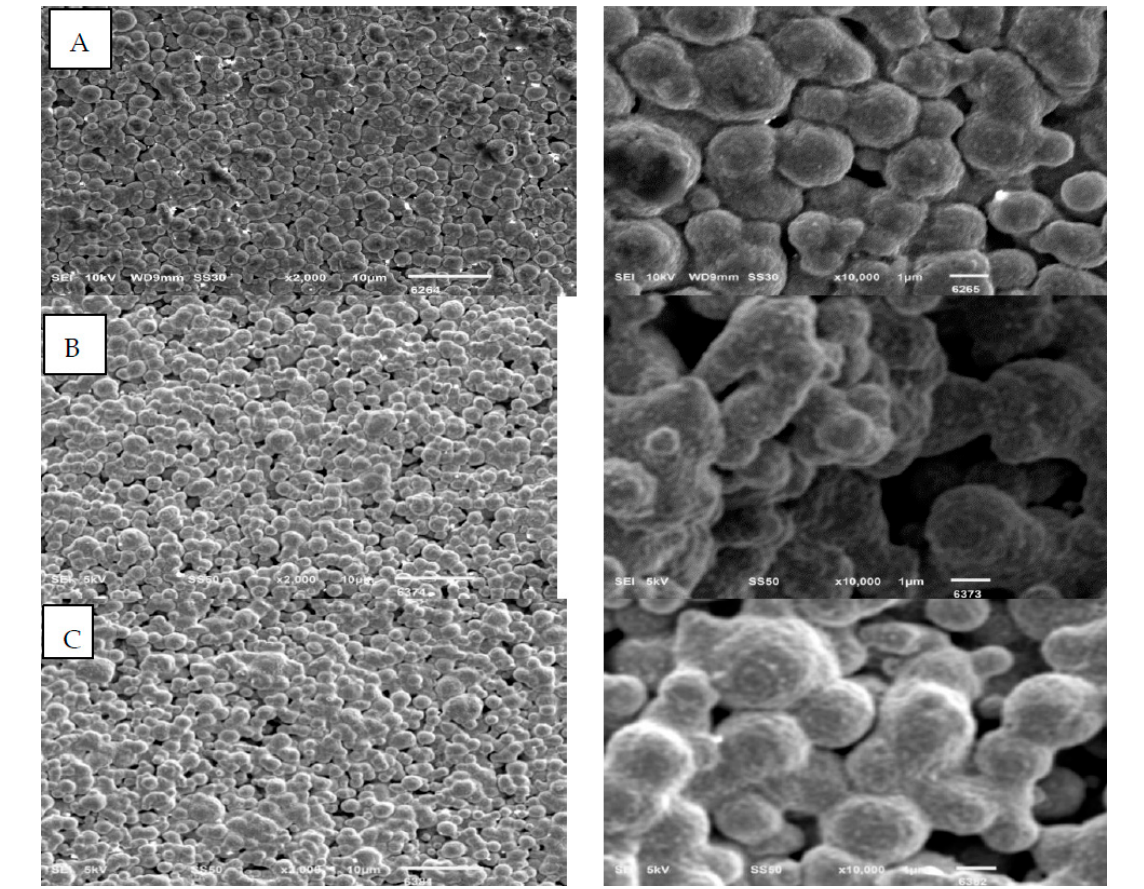
Figure A3. SEM images at low magnification showing surface morphology (left) and at high magnification showing details of the porosity (right), after calcination of the copper hollow fiber at 600 °C for ( A ) 1 ( B ) 3 and ( C ) 4 h.